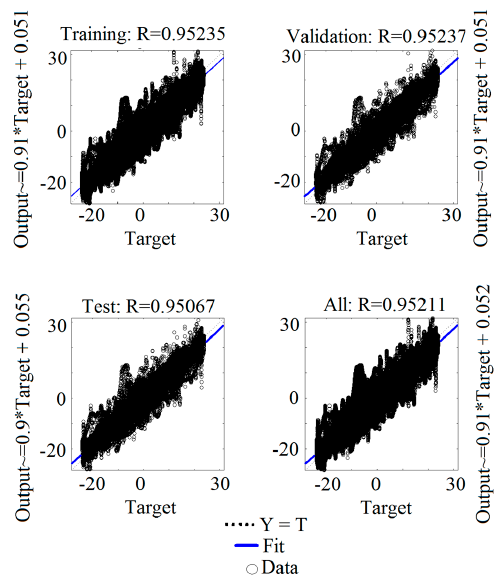
Figure 8. TDNN error histogram.